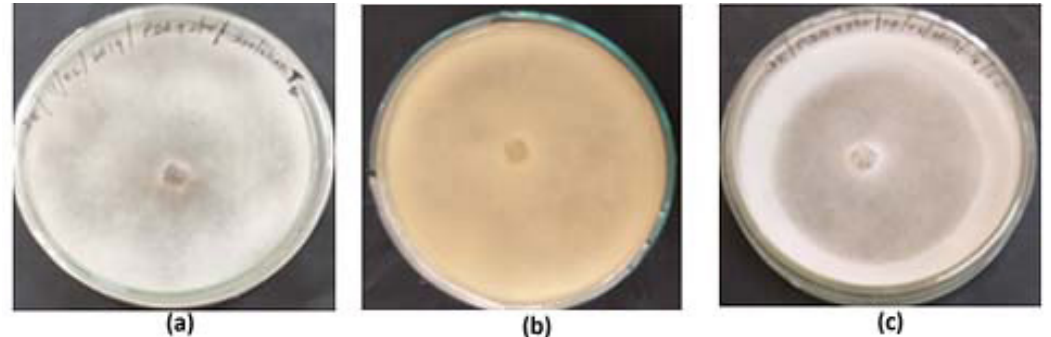
Figure 4: The pathogen isolates grown on PDA plate, (a) Surface view of a colony after 48 h, (b) under side of PDA plate after 48 h of inoculation, and (c) 14-days old culture.